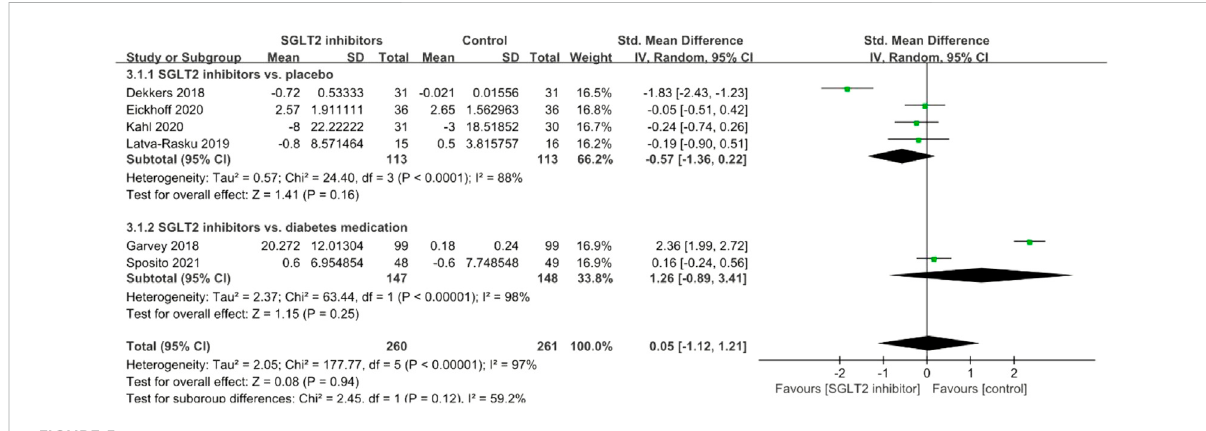
Forest plot of the effects of SGLT2 inhibitors on interleukin-6.